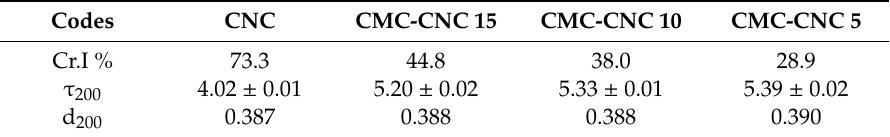
Table 2. Crystallinity degree, the crystallite sizes and d-spacing for the (200) crystallographic plane. Codes CNC CMC-CNC 15